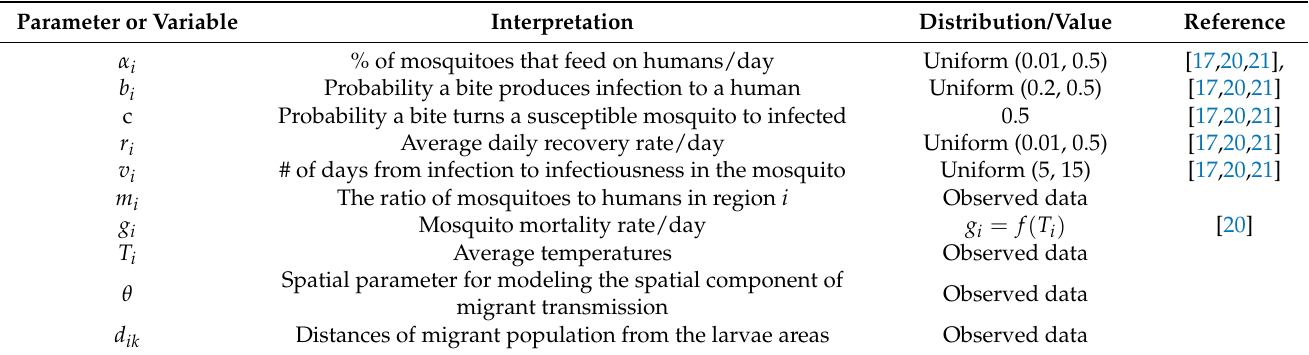
Table A3. List of parameters utilized for the calculation of risk measures and their interpretations along with correspond- ing